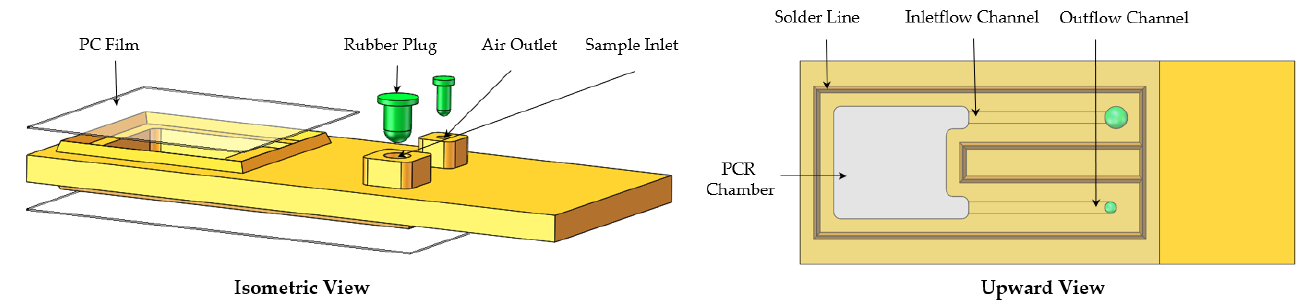
Figure 2. Labeled schematic of the microfluidic chip.